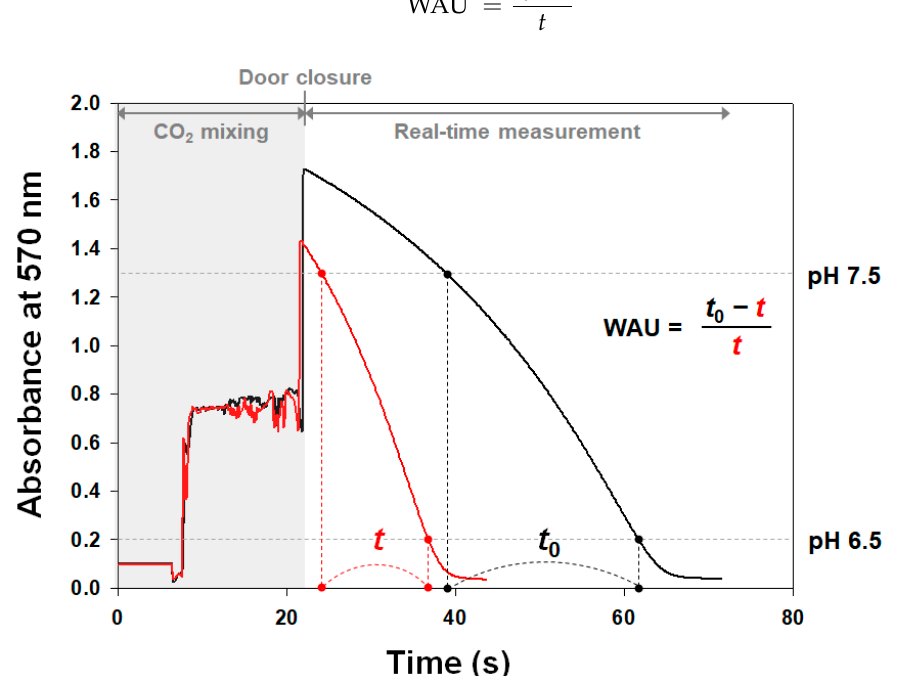
Figure 2. Data analysis for the calculation of enzyme activity in Wilbur–Anderson unit (WAU). The graph shows (black line) the noncatalyzed reaction and (red line) the enzyme-catalyzed reaction that were separately measured at 570 nm in a time-dependent manner.